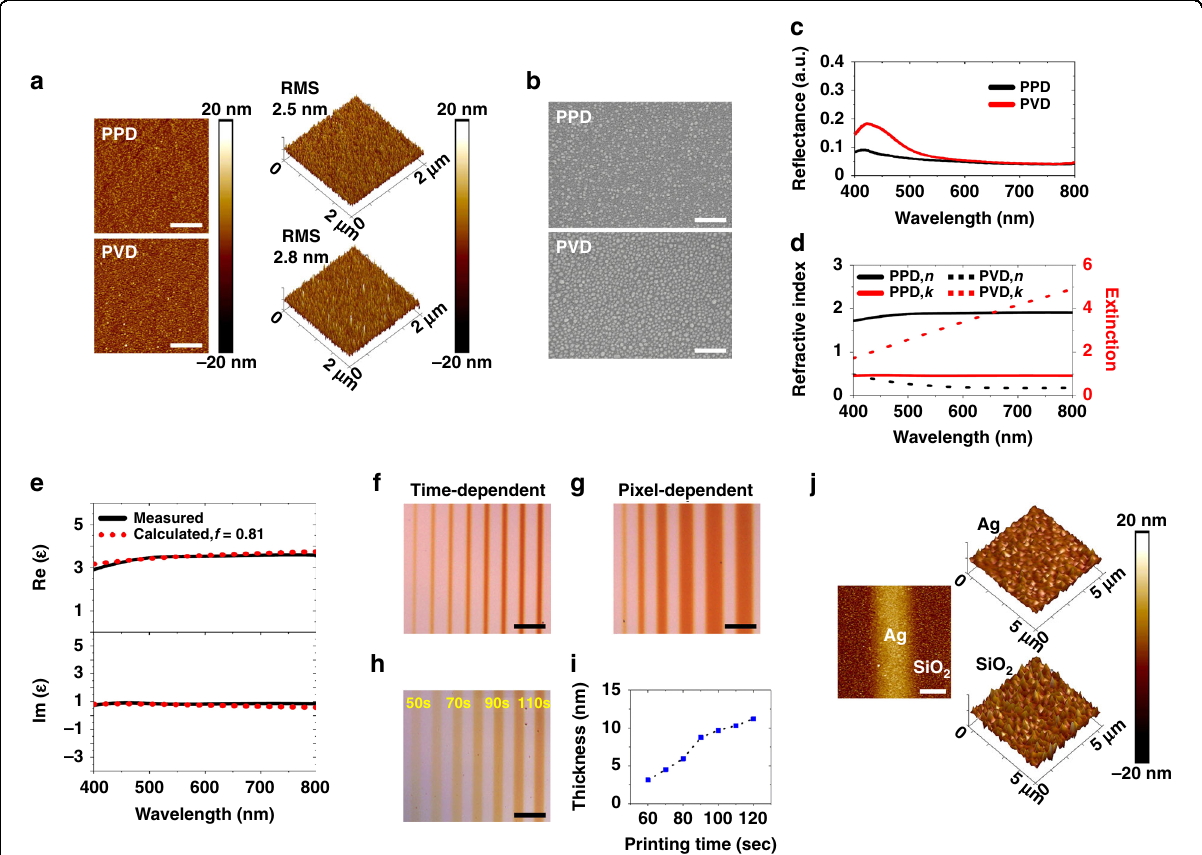
Fig. 2 Structural and optical characterization of PPD-printed ultra-thin fi lms. a – c Surface morphology and optical response of 4-nm-thick Ag fi lms prepared on fused silica substrate by PPD and PVD: a 2D (left, scale bar: 500 nm) and 3D (right) pro fi le of AFM images, b SEM images (scale bar: 200 nm), and c measured relative re fl ectance. d Measured optical properties ( n , in black; k , in red) of 15 nm Ag fi lms prepared on fused silica substrate by PPD (solid lines) and PVD (dot lines), respectively. e Measured (black solid line) and calculated (red dotted line) permittivities of PPD fi lm. Top: real part. Bottom: Imaginary part. f – h Optical images of PPD-printed lines on SiO 2 (200 nm)/PVD-Ag (85 nm) substrate: f single-pixel lines printed from 150 s (left) to 360 s (right), g single-pixel (left) to six-pixel (right most) lines printed at 150 s, and h four-pixel lines printed from 50 to 110 s. Scale bar: 50 μ m. i Printed PPD fi lm thickness as a function of printing time extracted from ( h ). j Surface morphology of PPD fi lm on SiO 2 (200nm)/PVD-Ag (85 nm) substrate. Left: 2D pro fi le of AFM image of 70 s printed four-pixel line from ( h ) (scale bar: 5 μ m). Right: 3D pro fi le of AFM images of the printed PPD Ag and sputtered SiO 2